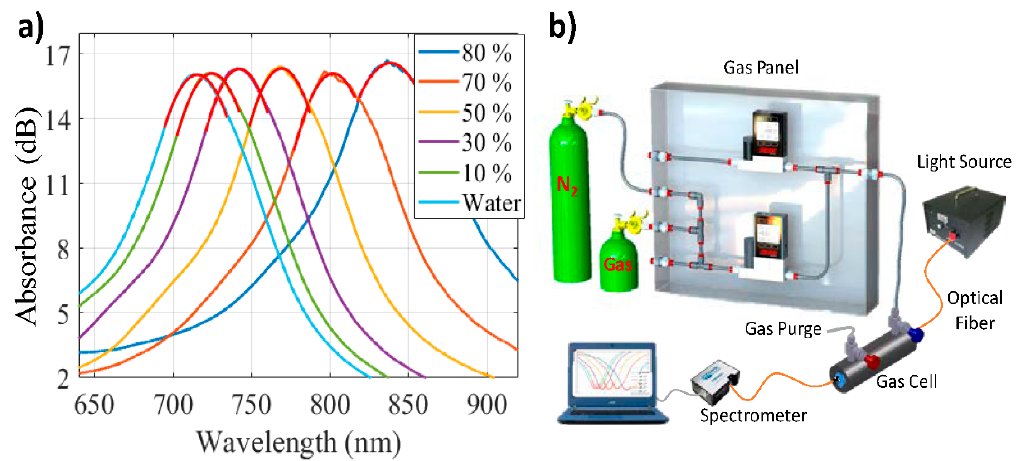
Figure 1. ( a ) Spectral response of the LMR refractometer when the sensitive region is immersed in different water/glycerin solutions at different concentrations (80% = 1.443 RIU, 70% = 1.428 RIU, 50% = 1.398 RIU, 30% = 1.370 RIU, 10% = 1.345 RIU, 0% = 1.333 RIU); ( b ) Experimental setup used to monitor the sensitivity of the device to different gases that consisted of a gas cell with an optical fiber pass-through for fiber connections to the optical source and detector as well as gas inlet and